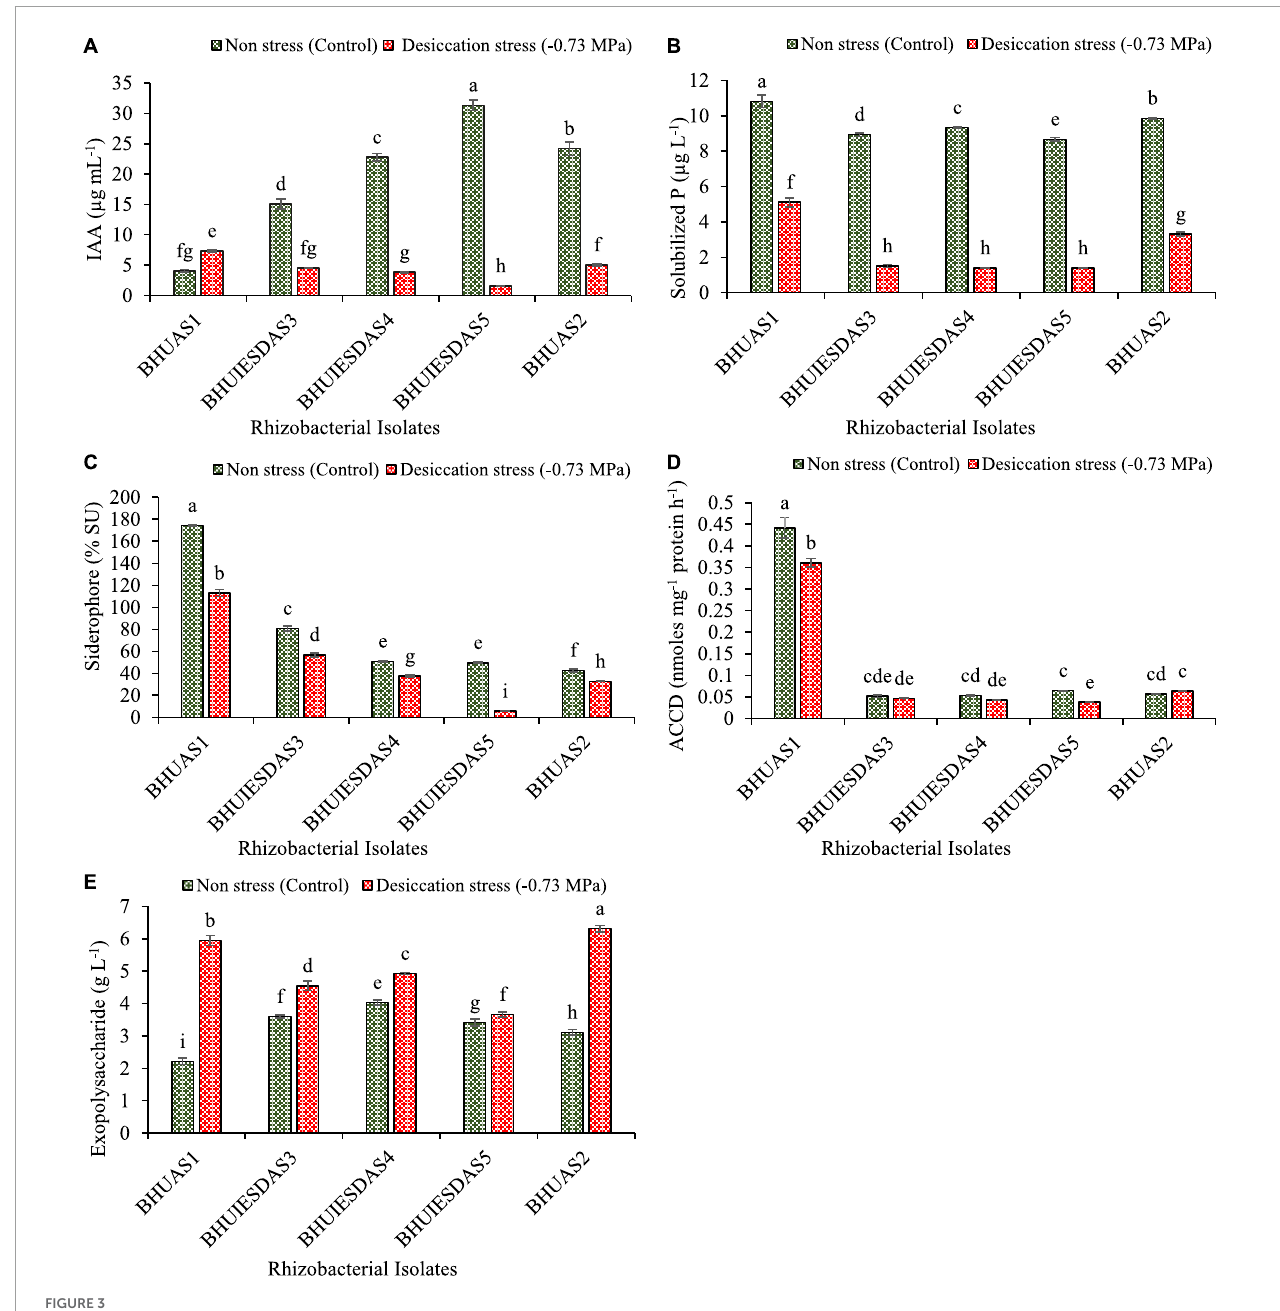
FIGURE3 Expression of plant growth-promoting features of five selected desiccation-tolerant bacterial strains under non-stress and impacts of desiccation stress (A) amount of IAA produced, (B) amount of solubilized phosphate liberated, (C) amount of Fe chelating siderophore produced, (D) amount of ACC deaminase expressed, and (E) amount of exopolysaccharide produced. The different alphabets indicate statistically significant differences between each treatment (DMRT p <